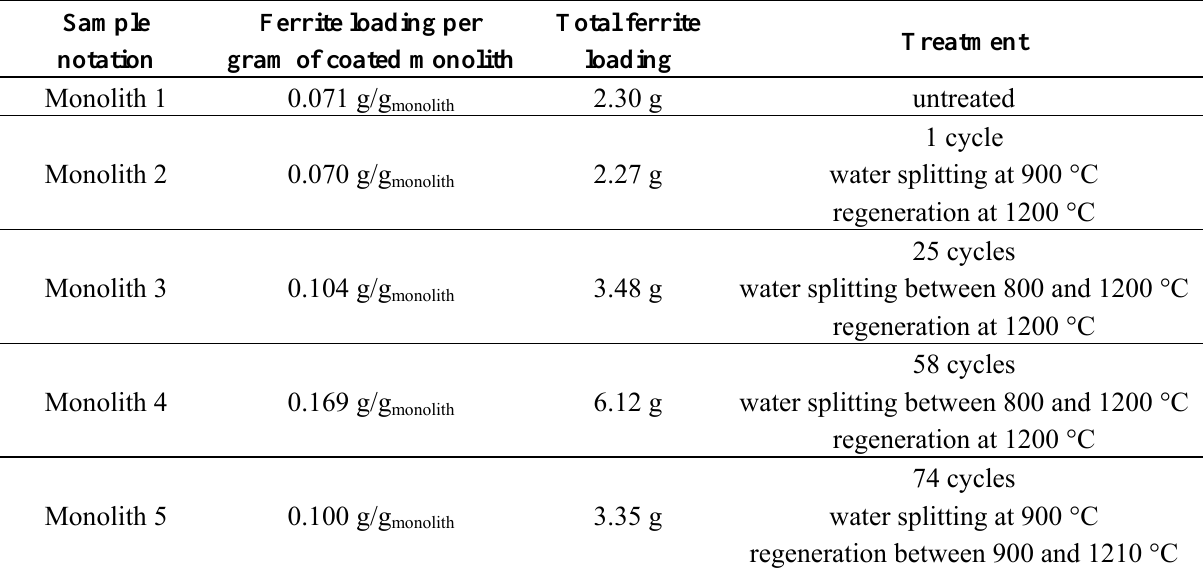
Table 1. Overview of investigated coated honeycomb